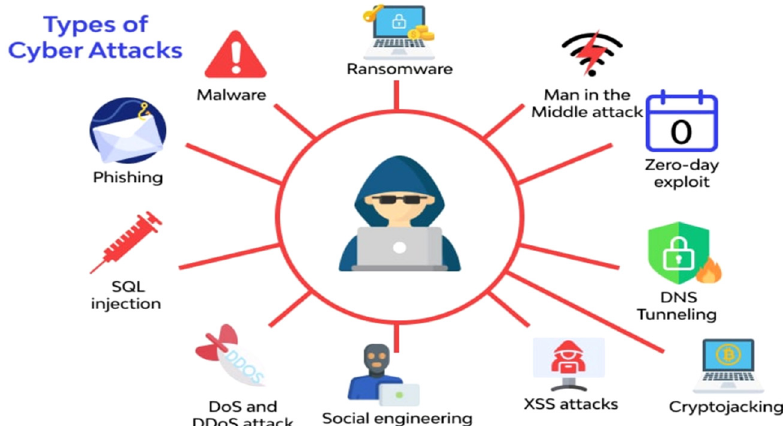
Figure 2: Types of cyber - attacks [ 18 ]